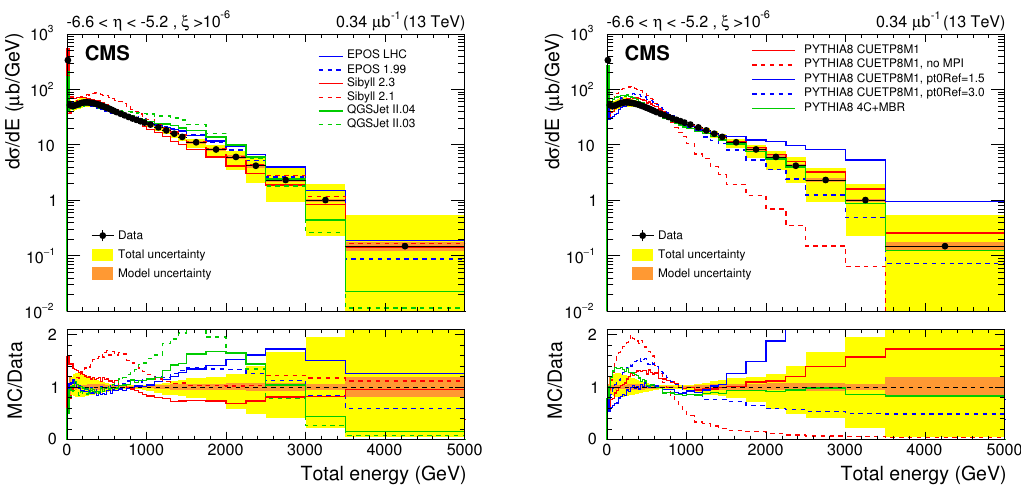
Figure 3 . Di(cid:11)erential cross section as a function of the total energy in the region (cid:0) 6 : 6 < (cid:17) < (cid:0) 5 : 2 for events with (cid:24) > 10 (cid:0) 6 . The left panel shows the data compared to MC event generators mostly developed for cosmic ray induced air showers, and the right panel to di(cid:11)erent pythia 8 tunes.